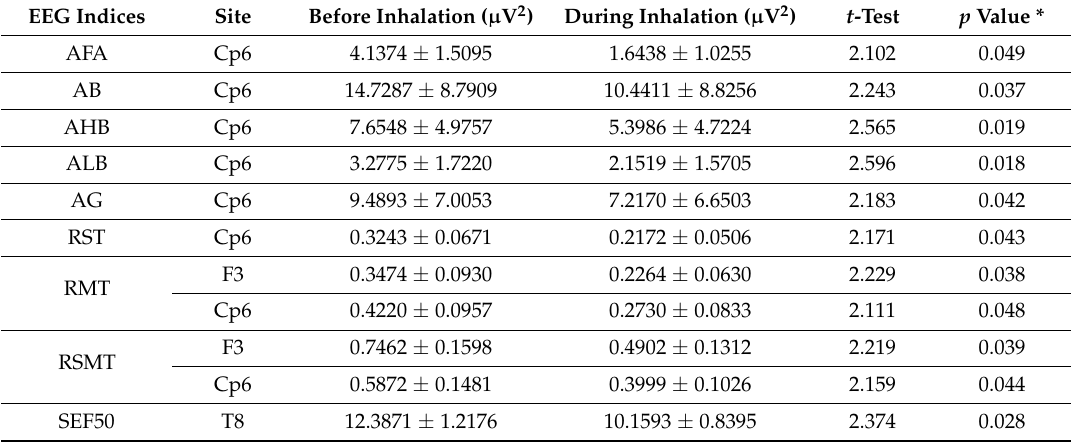
Table 1. Significant changes of EEG power spectra during the inhalation of geosmin in both genders. EEG